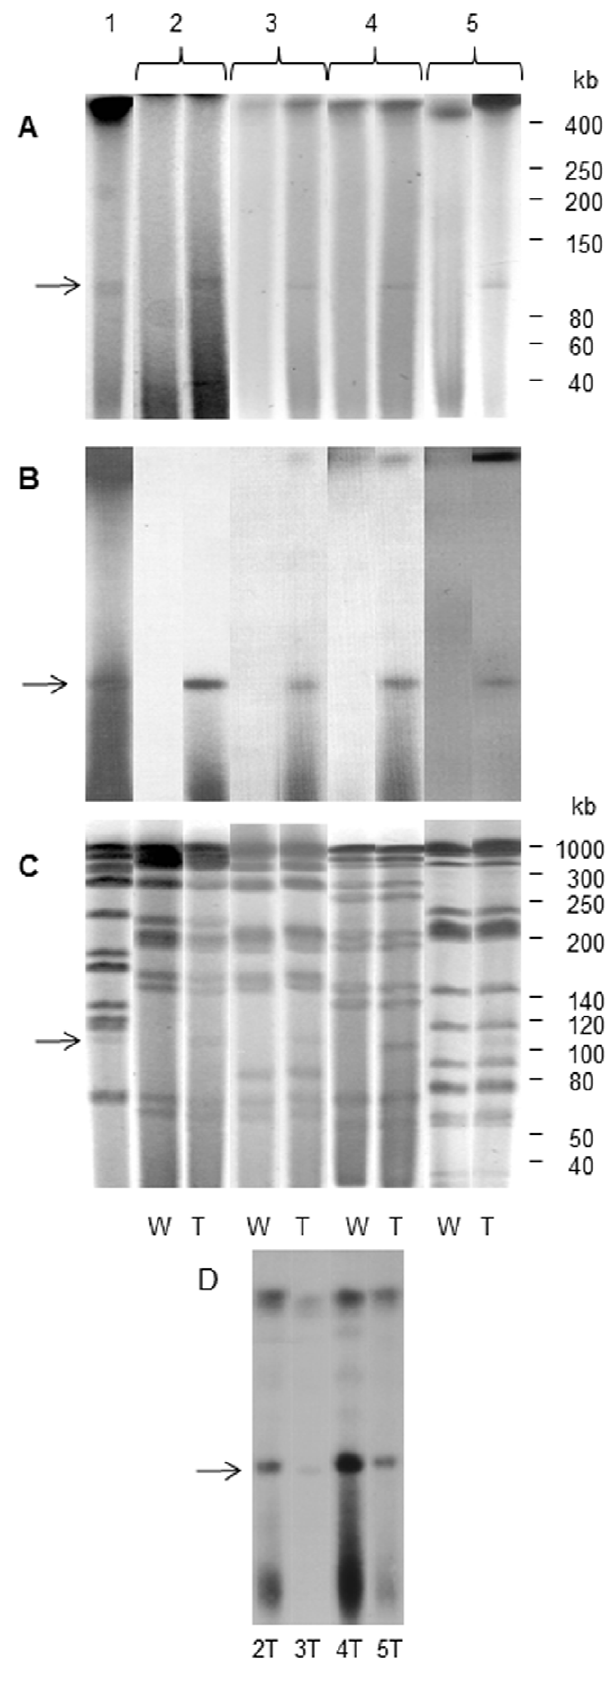
Figure 4. Analysis of transconjugants isolated in mating experiments using M.avium 88.3 as donor strain. (A) PFGE with undigested DNA; (B) Southern blot of PFGE gels with undigested DNA and hybridization with IS 1245 -derived probe; (C) PFGE-DraI; (D) Southern blot of PFGE-DraI gels and hybridization with pMA100- derived probe. Open arrows indicate the linear plasmid pMA100. 1: M. avium 88.3; 2: M. kansasii 88.6; 3: M. kansasii IAL 413; 4: M. kansasii IEC 6805; 5: M. bovis BCG Moreau; W: wild-type colony; T: transconjugant